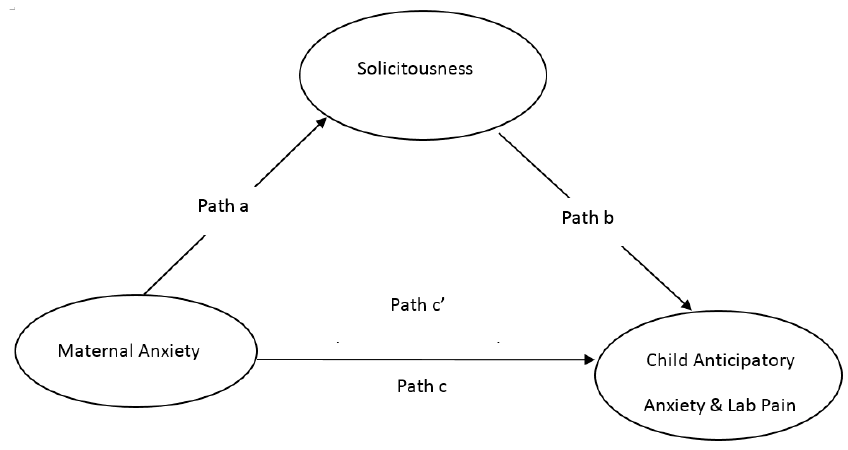
Figure 1. Conceptual model of maternal anxiety, responses to child pain, and dependent child laboratory pain variables.